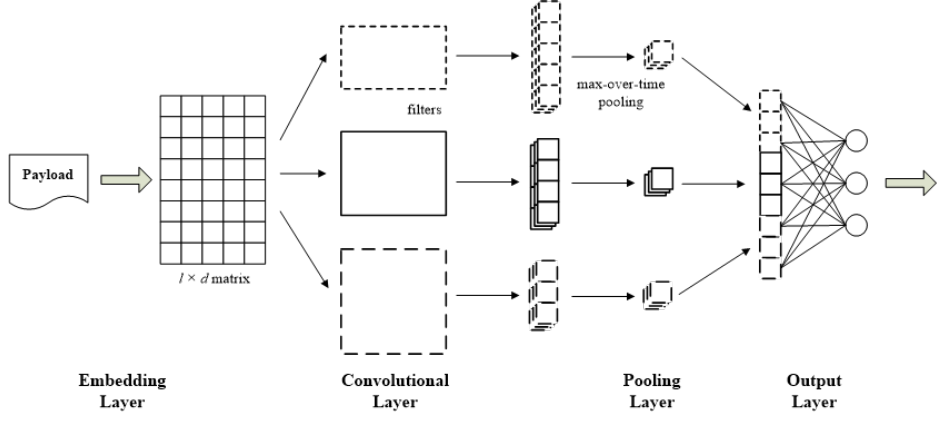
Figure 2. The architecture of